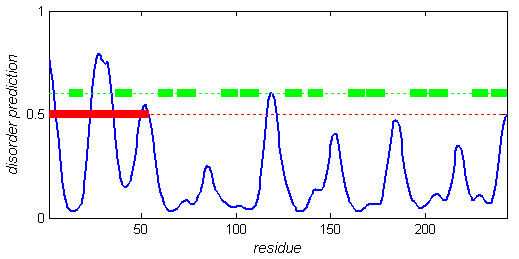
VSL2 prediction on PDB chain 1 YYH:B. VSL2 prediction (disorder probability) is plotted in blue sold line. Residues with predictions above 0.5 are interpreted as predicted disordered. The long region of missing electron density (residues 1–54) is marked as thick red segment. The fourteen short green segments correspond to the α-helices in the seven ANK repeats (two helices for each repeat).